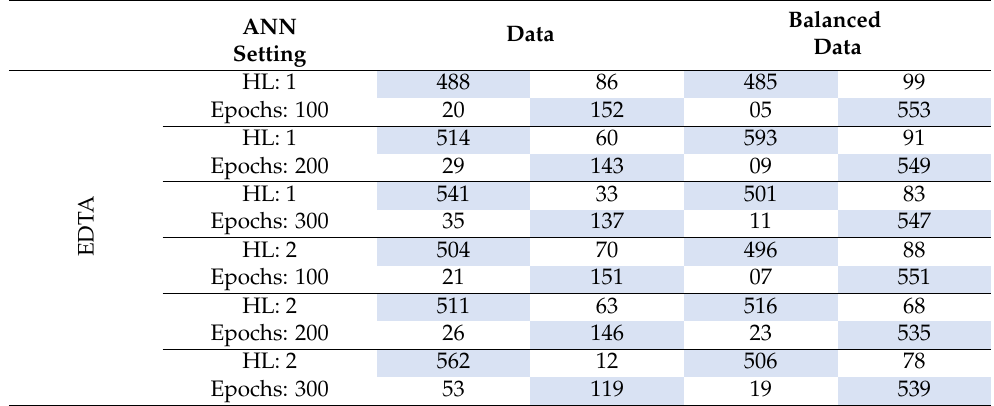
Table 8. Confusion matrix for each scenario. SF in tubes with EDTA.